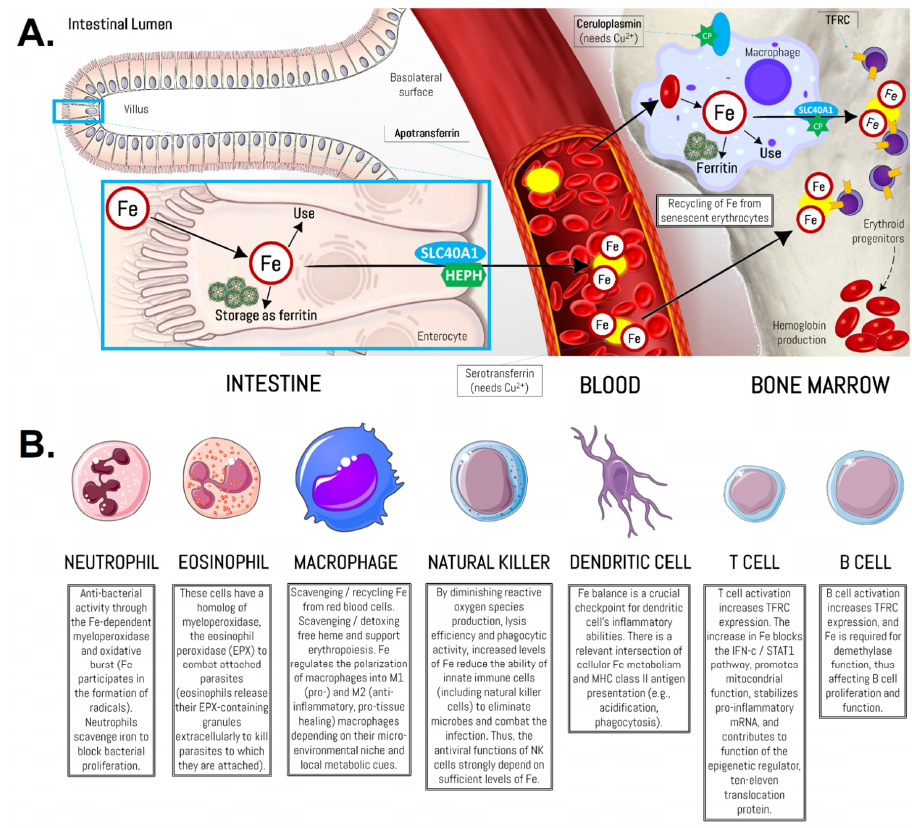
Figure 4. Integration of iron metabolism to hemoglobin production and immune cell function. ( A ) The figure represents the integration of Fe to hemoglobin through bone marrow macrophages. Blue ovals represent the SLC40A1 (also known as ferroportin). The green six-pointed star represents ceruloplasmin (CP), which needs Cu 2+ . Bright yellow ovals are pointed with arrows as apotransferrin (TF) while the orange bar on the membrane of erythroid progenitors (purple cells) represents the TFRC. ( B ) Fe bioavailability orchestrates complex metabolic programs in immune cell function and inflammation (for comprehensive reviews on this topic, please refer to [83,102–104] ). Fe, iron; HEPH, hephaestin; SLC40A1, solute carrier family 40 members 1; TFRC, transferrin receptor protein 1. Source: designed by the authors (D.A.B.) using figure templates developed by Servier Medical Art (Les Laboratoires Servier, Suresnes, France), licensed under a Creative Common Attribution 3.0 Generic License. http://smart.servier.com/ (accessed on 20 February 2021). In parallel, Fe 2+ ion is a component of several metalloenzymes (forming the so-called iron-sulfur [Fe-S] clusters) [105,106]. These Fe-S clusters are indispensable for the viability of the cell (e.g., DNA maintenance, transcription/translation processes, and metabolic regulation) and might assemble not only in mitochondria but also in the cytosol and nucleus [107]. Furthermore, Fe is required in the formation of reactive oxygen species (ROS) [108,109] and, thereby, it is a critical component of key enzymes during the process